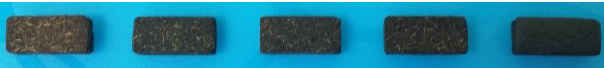
Figure 2: Fabricated samples of coir, 5wt% charcoal, 10wt% charcoal, 15wt% charcoal and charcoal respectively from left to right